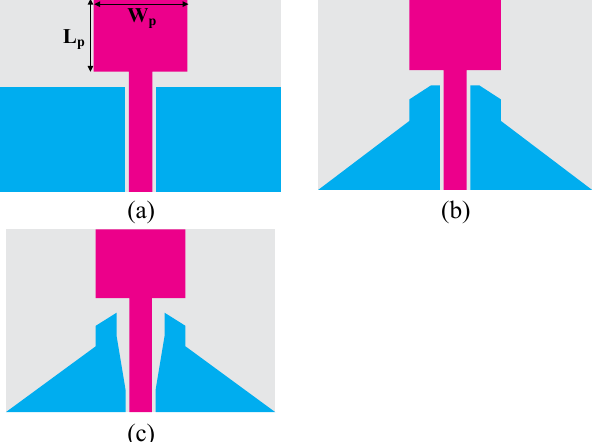
FIGURE 4. Radiating patch design procedure: (a) square patch (Ant III), (b) bevelled patch (Ant IV), and (c) proposed patch (Ant V).